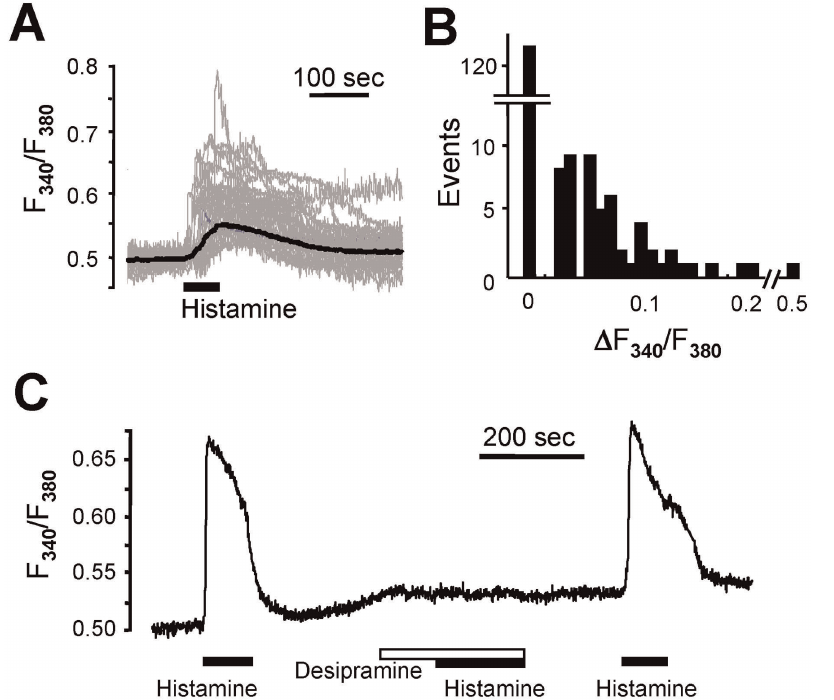
Figure 1. Desipramine inhibits histamine-induced [Ca 2 + ]i rise in primary cultured rat hypothalamic cells. (A) Fura-2-loaded primary cultured rat hypothalamic cells were challenged with 100 m M histamine. The change in fluorescence ratio of F 340 /F 380 was measured. Gray traces represent the individual responses from each dissociated cell, and their average is depicted with a black trace. (B) Histogram of net changes in fluorescence ratio triggered by 100 m M histamine. (C) Primary cultured rat hypothalamic cells were challenged with 100 m M histamine (black bar) in the presence or absence of 30 m M desipramine (white bar). Typical [Ca 2 + ]i traces from more than three separate experiments are presented. All results were